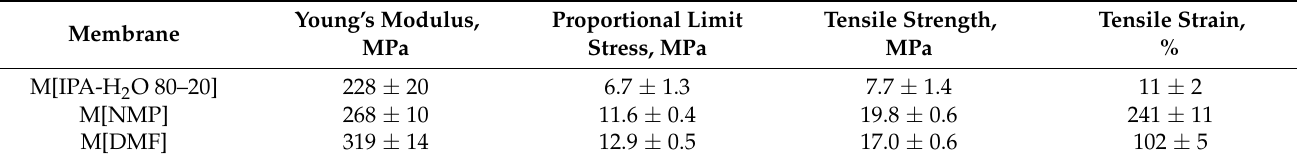
Table 2. Mechanical properties of membranes in H + -form kept at RH = 32%.